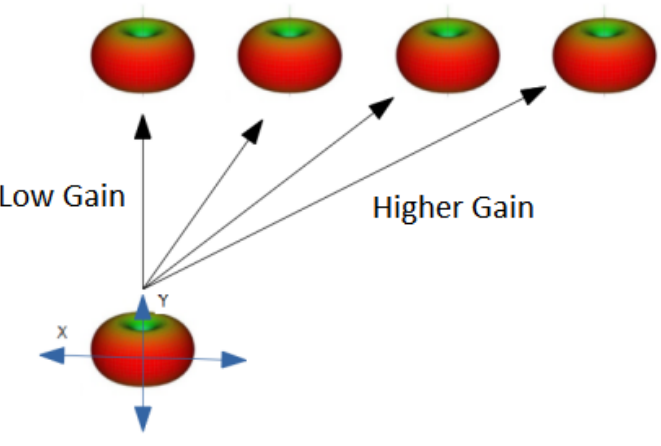
Figure A2. Illustration of gain composition of the BS and drone